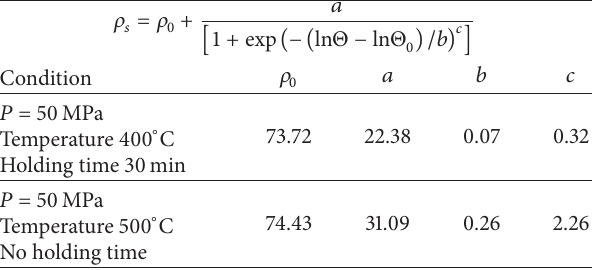
Table 3: The coefficients in the master sintering curves for Al-Mg alloy